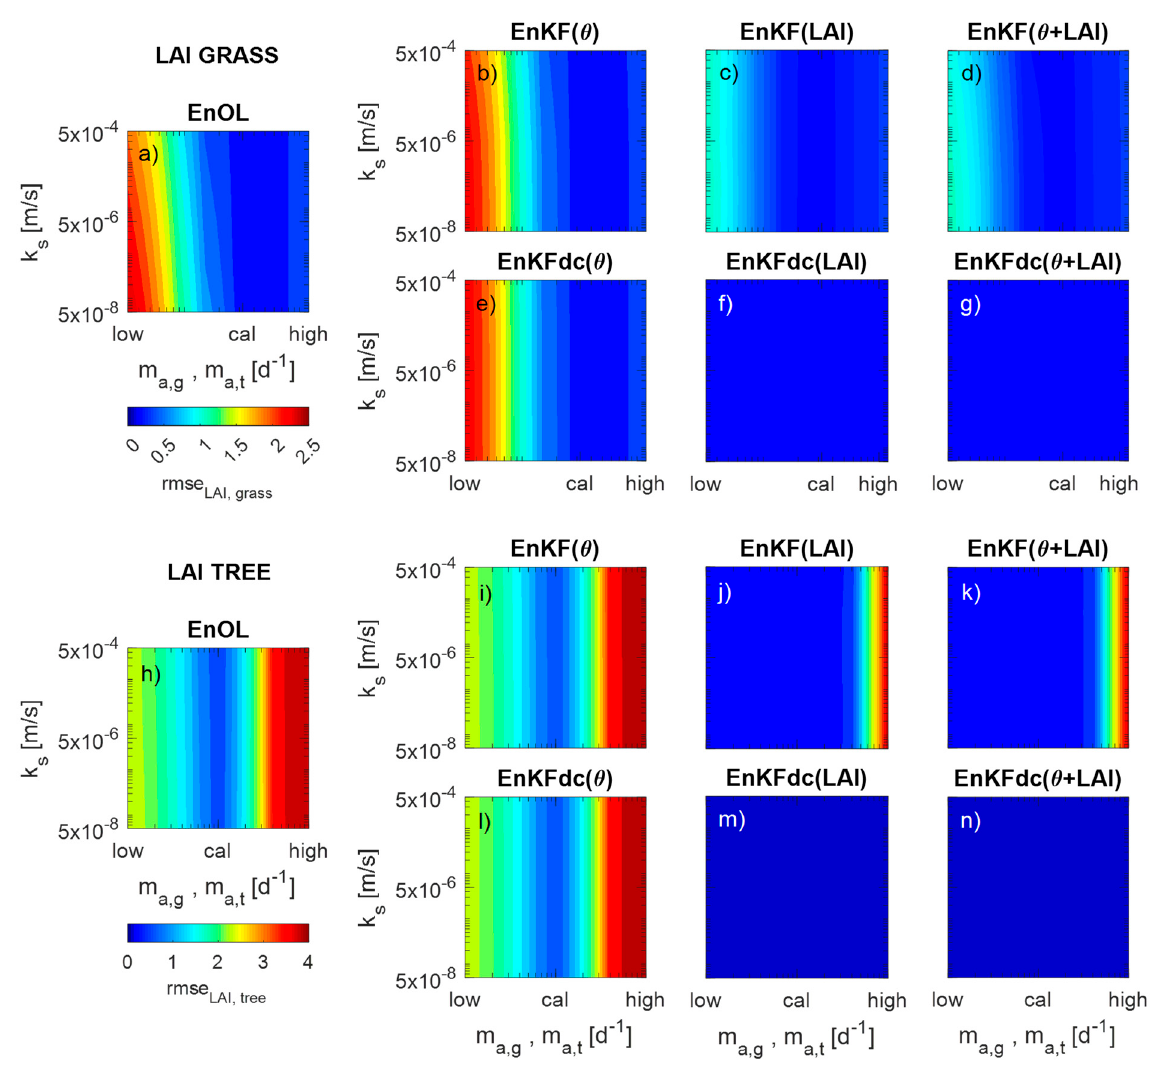
Figure 6. Same as Figure 5 but ( a – g ) for the root mean square error (RMSE) of the grass leaf area index (LAI), and ( h – n ) the root mean square error (RMSE) of the tree leaf area index (LAI).